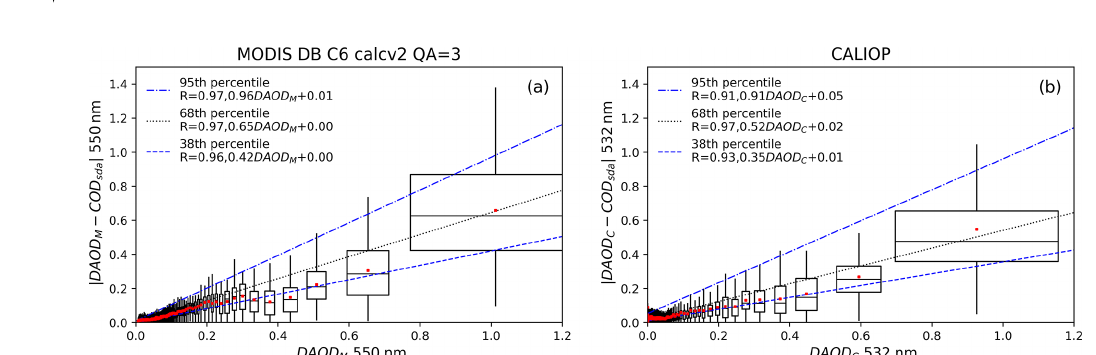
Figure 1. Scatter density histogram comparing monthly (from 2007 to 2019) MODIS DAOD (a) and CALIOP DAOD (b) with monthly coarse-mode COD SDA retrieved at 550nm for MODIS comparison and at 532nm for CALIOP comparison from the level 2 (cloud- screened and quality-assured) spectral deconvolution algorithm (SDA) version 4.1 (O’Neill et al., 2003). The 1-to-1 line and linear re- gression line are shown by dotted and solid lines, respectively. The number of sites (Sites), matchups ( N ), correlation ( R ), slope ( S ), constant ( C ), and root mean square error (RMSE) of the linear regression as well as absolute bias ( B a ) and relative Bias ( B r ) are indi- cated in the lower right of the panel. B a , B r , and RMSE are defined as B a = DAOD CorM − COD SDA , B r = DAOD CorM / COD SDA − 1, (cid:114) (cid:80) − COD SDA ,i ) 2 i ( DAOD CorM ,i RMSE = . N